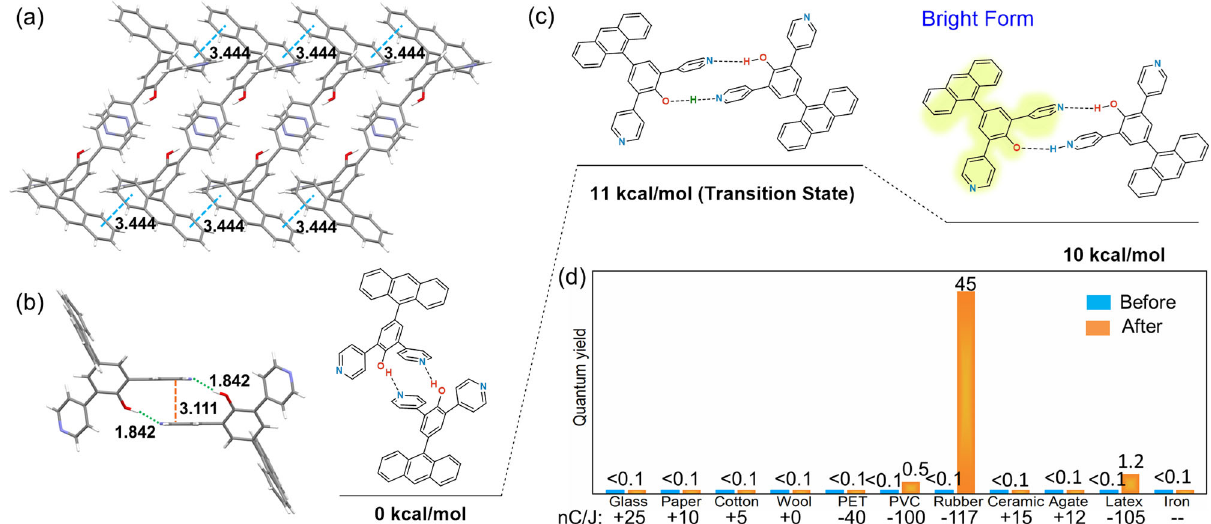
Fig. 3 Mechanism investigation. X-ray crystallographic structure of seven in ( a ) a packing view and ( b ) a dimeric view; c energy calculation diagram of a proposed proton transfer process in the double H-bonded dimer of 7; d The quantum yield of the solid sample of 3 before and after rubbing with different